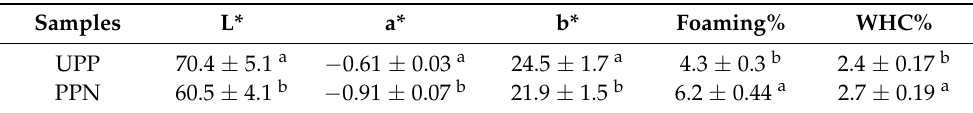
Table 1. Colorimetric study, foaming, and water holding capacity (WHC) of untreated pea protein (UPP) and pea protein nanoemulsion (PPN).